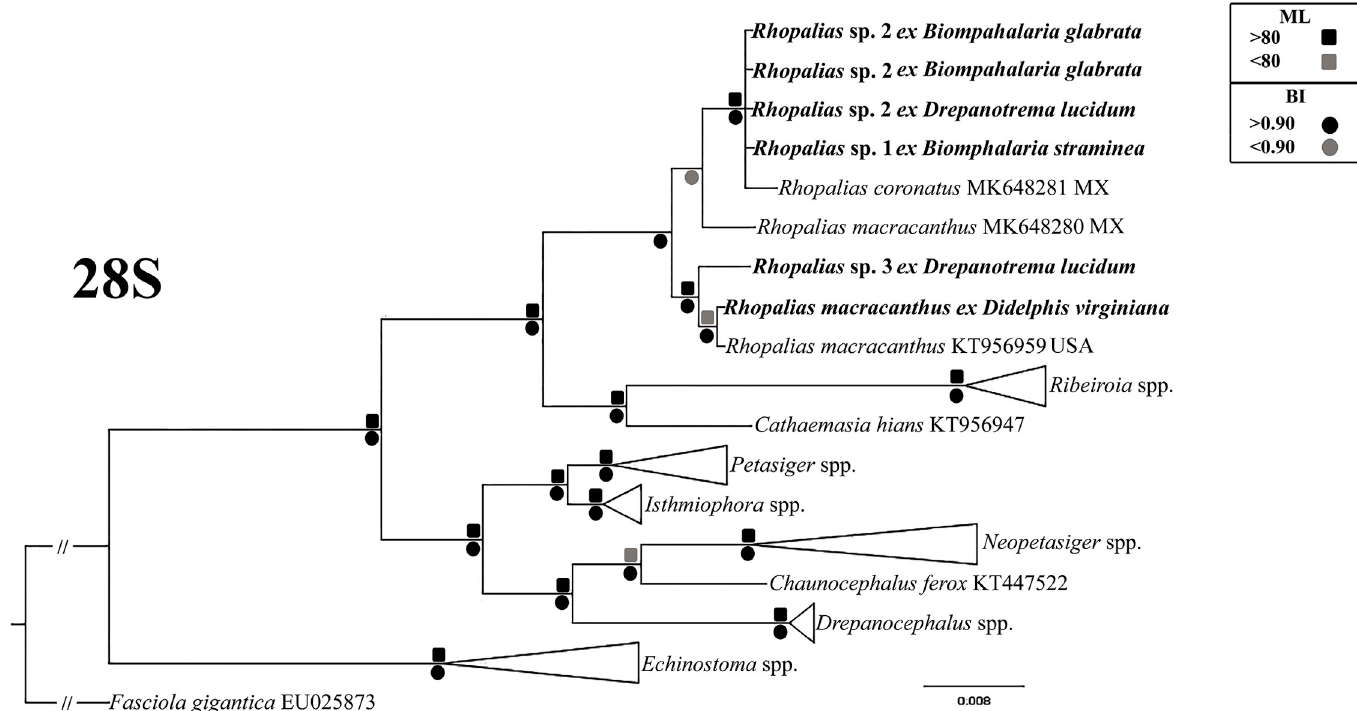
Fig 1. Phylogenetic relationships between Rhopalias spp. found in planorbids from Brazil and members of the family Echinostomatidae inferred from partial 28S sequence data (1077 bp). The trees were generated by Bayesian Inference (BI) and Maximum Likelihood (ML) methods. New sequences from the present study are in bold. Scale bar represents the number of nucleotide substitutions per